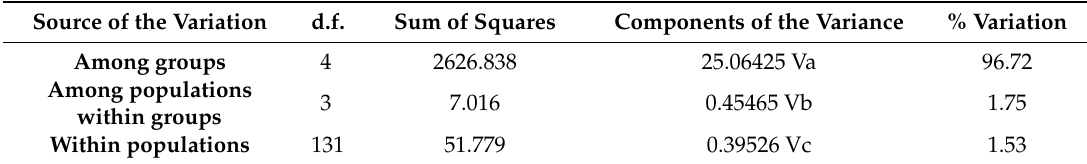
Figure 4. Haplotype network of the five mitochondrial lineages (MOTUs) identified in Brycon falcatus. Each circle represents a single haplotype and its size is proportional to its frequency. Table 1. Analysis of Molecular Variance (AMOVA) of the samples of Brycon falcatus .